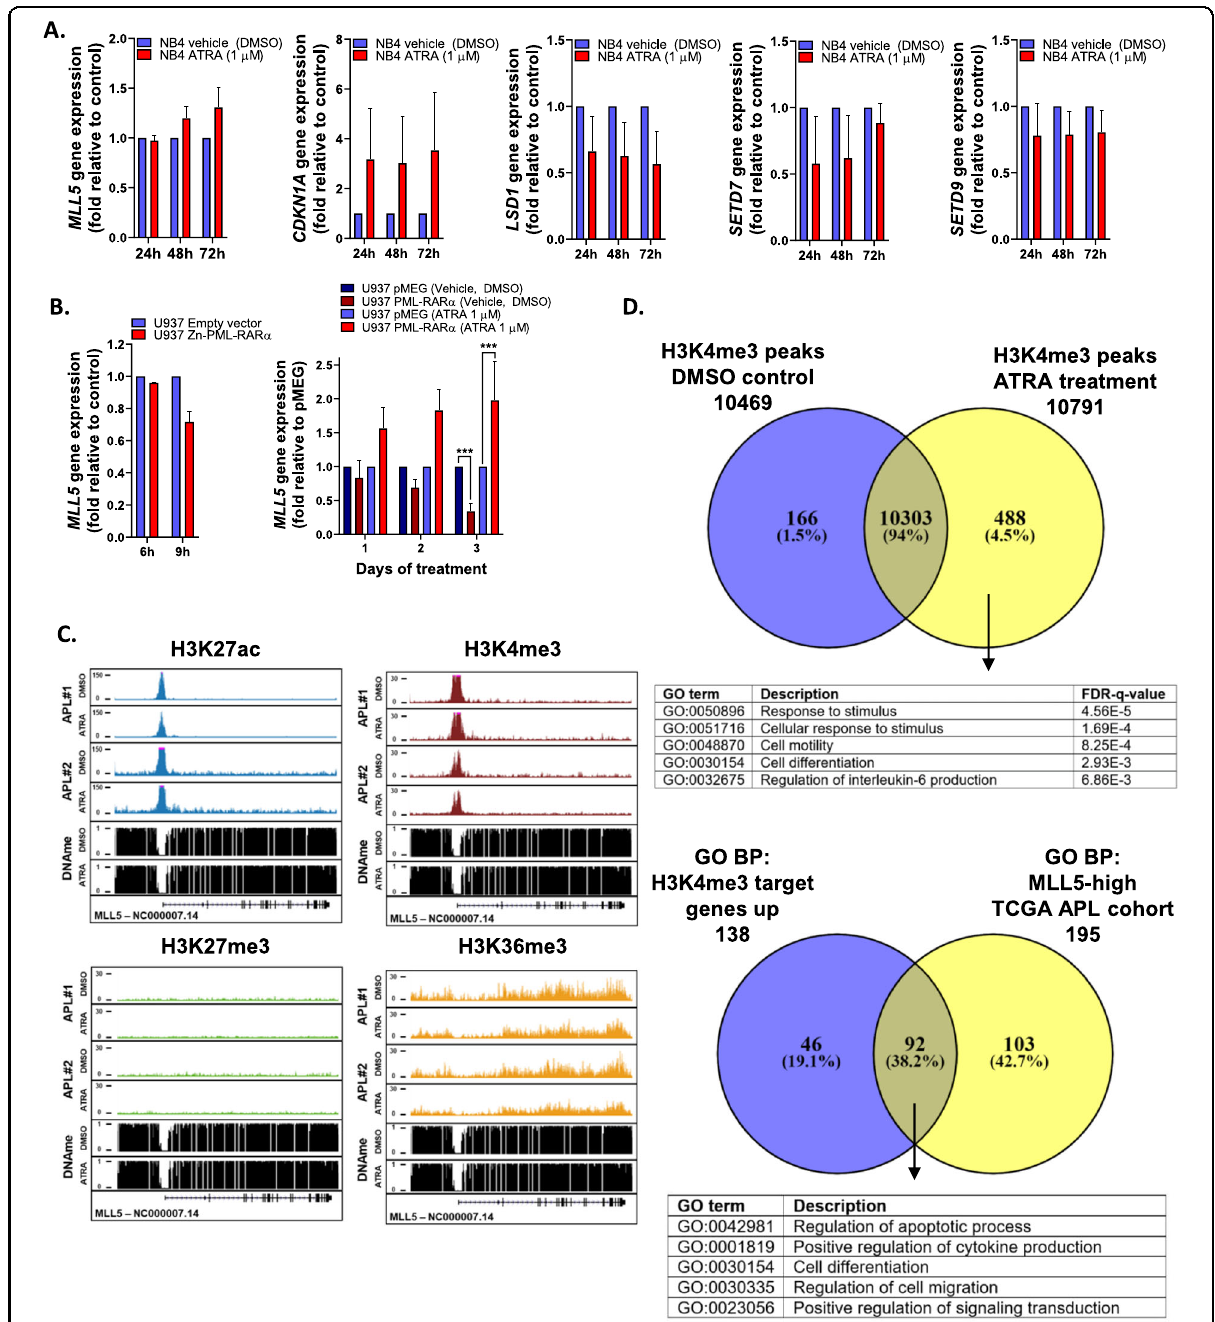
Fig. 3 Molecular effects of ATRA treatment in PML-RAR α + cells. A Gene expression analysis of MLL5 , LSD1 , SETD7 , SETD9 , and CDKN1A in NB4 cell line treated with vehicle (DMSO) and ATRA (1 µM) for 24, 48 and 72 h. Expression data was retrieved from GSE19201 and GSE18397. B Gene expression analysis of MLL5 in U937 cell line infected with empty-vector and Zinc-inducible PML-RAR α (left panel). The expression of MLL5 gene was quanti fi ed 6 and 9 h after Zinc administration. Gene expression analysis of MLL5 in U937 cell line infected with empty-vector and PML-RAR α (bcr1 isoform; right panel). Cells were treated with ATRA (1 µM) and DMSO control for 1, 2 and 3 days. Data were expressed as mean ± standard error of the mean. C Overview of APL ChIP-seq (H3K27ac, H3K4me3, H3K27me3 and H3K36me3) data at the genomic regions of the MLL5 gene before and after ex vivo ATRA treatment. D Upper panel exhibit the overlap in H3K4me3-bound loci determined by ChIP seq in APL patient#1. Peaks were distinguished in present only in DMSO control, only upon ATRA treatment and in both conditions. Overall, 488 genes were enriched only upon ATRA treatment, which were associated with 138 gene ontology (GO) — biological process (BP). Lower panel exhibit the GO BP for H3K4me3 up regulated genes present only upon ATRA-treatment and the GO BP found in APL patients from the TCGA cohort with high MLL5 expression. ChIP-seq data was retrieved from GSE18886. * P < 0.05. ** P < 0.01. *** P < 0.001. NS indicates not signi fi cant.